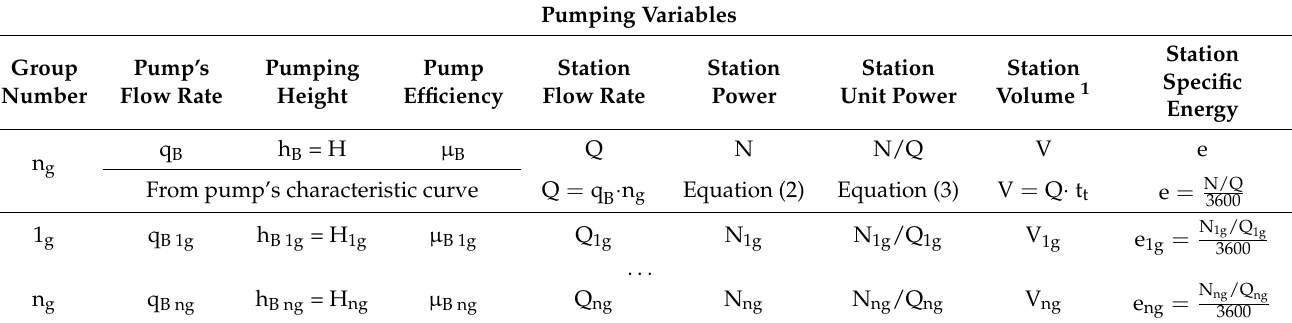
Table 1. Key variables of the pump station.